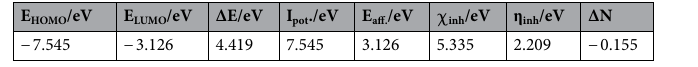
Table 4. QCC parameters for DTG